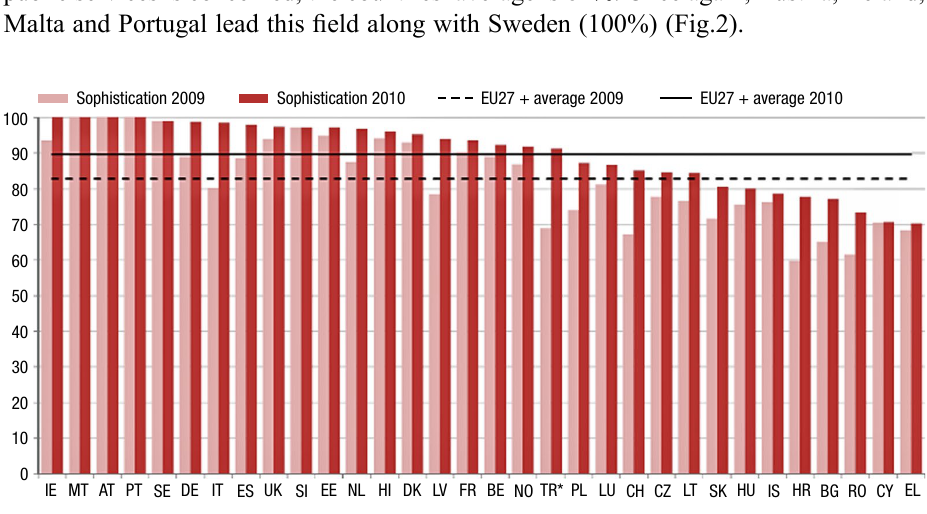
Fig. 1. Ranking of European countries by online sophistication (in %) Notes: * Survey not implemented in 2009. The score of 2007 is used in the graph. Source: Capgemini et al. (2010: 7).